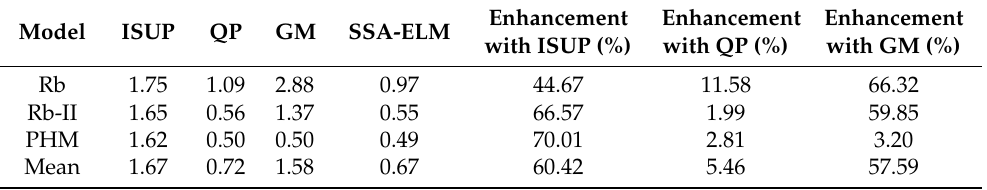
Figure 16. The residual plot of the SSA-ELM model using the 6th hour update ultra-fast clock product of the day. ( a ) The residual value of BDS-2 predicted after 6 h. ( b ) The residual value of BDS-3 predicted after 6 h. Table 5. The average RMS values of 3 h for different prediction models based on 24 h of SCB data (ns).